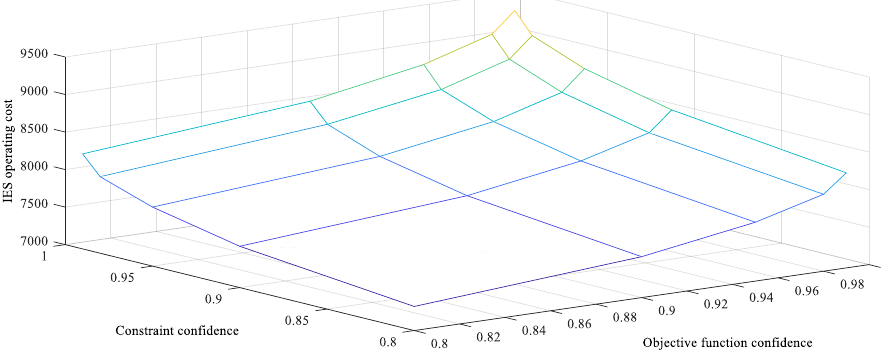
Figure 11. The relationship between the planned operating cost and the confidence degree of the IES for a typical summer day.